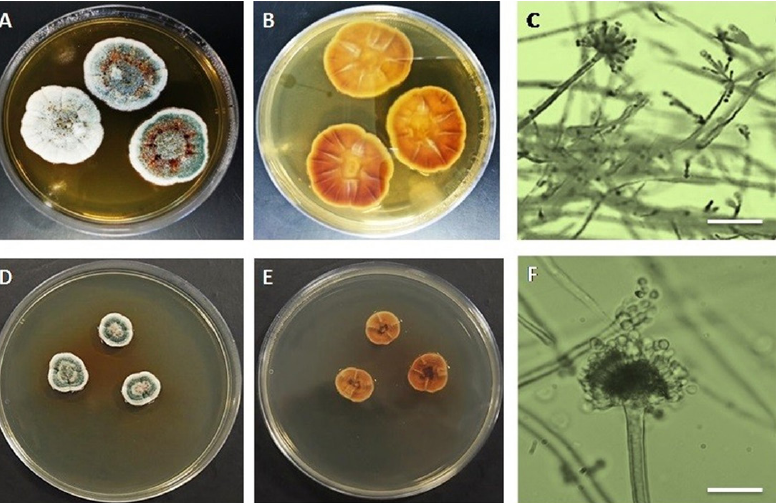
Fig. 2. Aspergillus vericolor A & B. Surfaceand reverse on MEA C. Two pattern of coniophores (aspergillate and penicillate structures) D&E. Surface and reverse on YES agar F. Conidiophore with conidial head (Bar in C & F = 400 µ